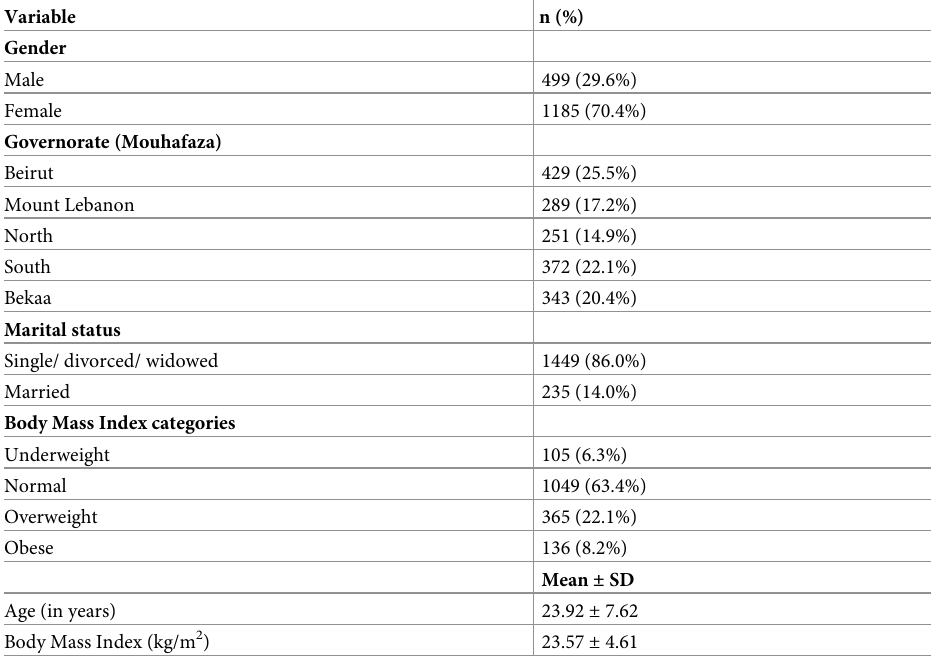
Table 1. Sociodemographic characteristics of the participants (N =